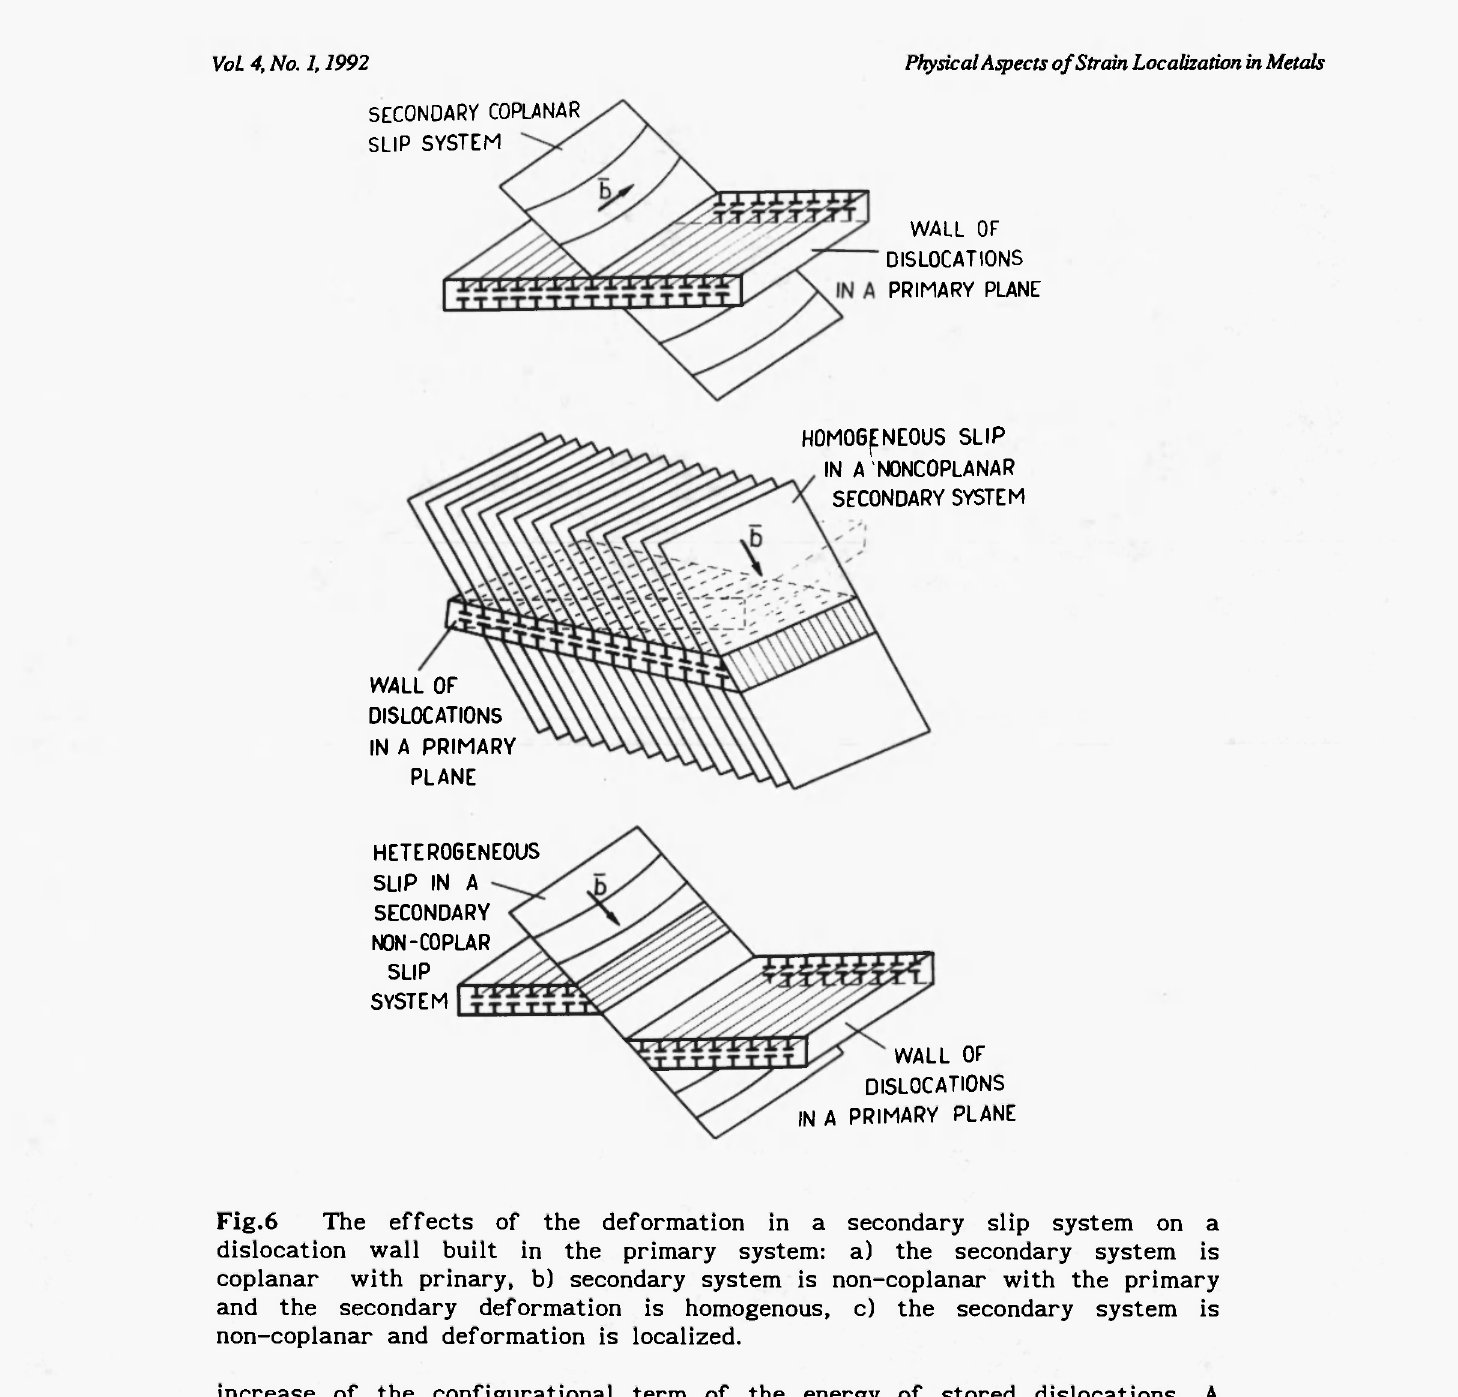
The effects of the deformation in a secondary slip system on a dislocation wall built in the primary system: a) the secondary system is coplanar with prinary, b) secondary system is non-coplanar with the primary and the secondary deformation is homogenous, c) the secondary system is non-coplanar and deformation is